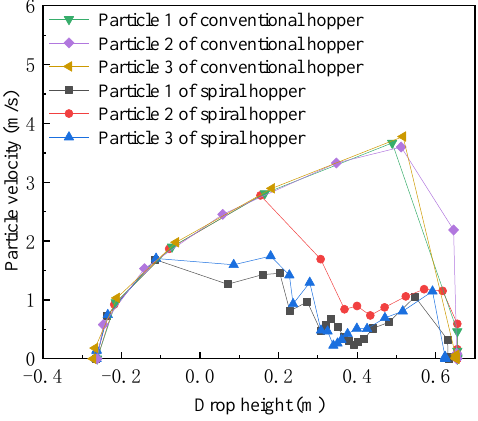
Figure 5. Particle velocity in the transfer process.